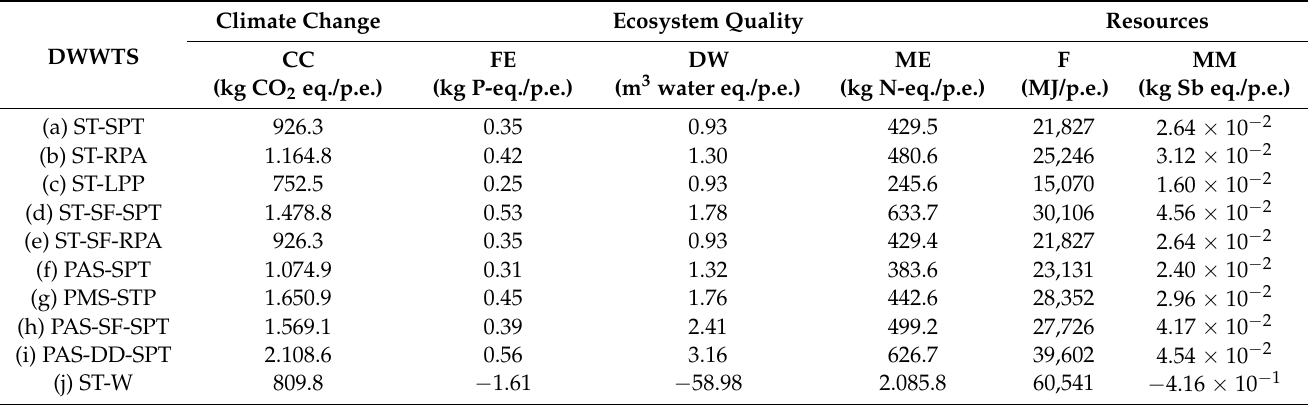
Table 4. Cumulative environmental burdens per population equivalent (p.e.) for each DWWTS during its construction and operation life cycle. Climate Change Ecosystem Quality DWWTS